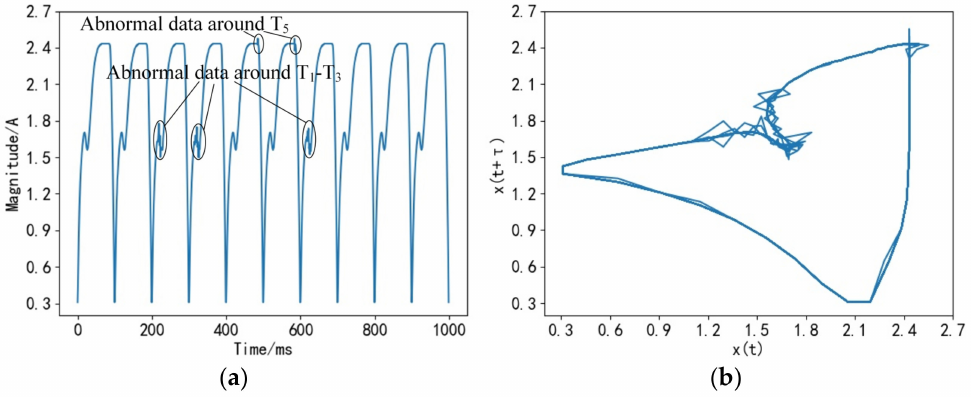
Figure 5. Current signals containing data fluctuation anomalies and corresponding reconstructed phase trajectory: ( a ) current signal; ( b ) reconstructed phase